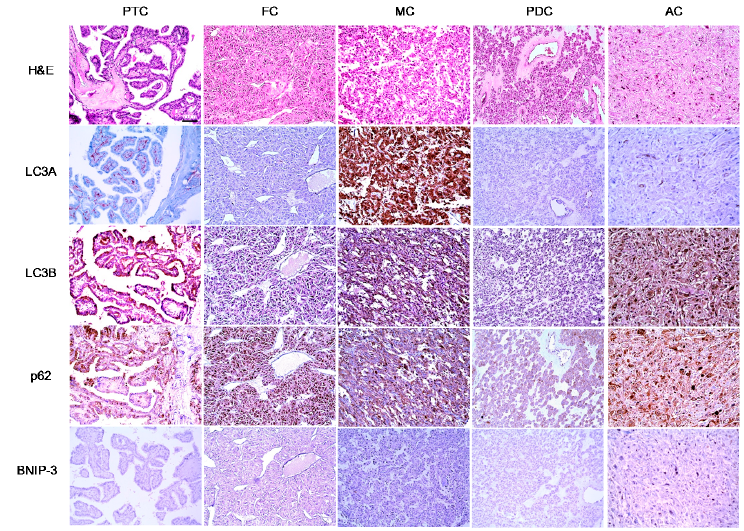
Figure 1. Expression of autophagy-related proteins in different types of thyroid cancer (Original magnification ×200; Scale bar, 50 μ m).